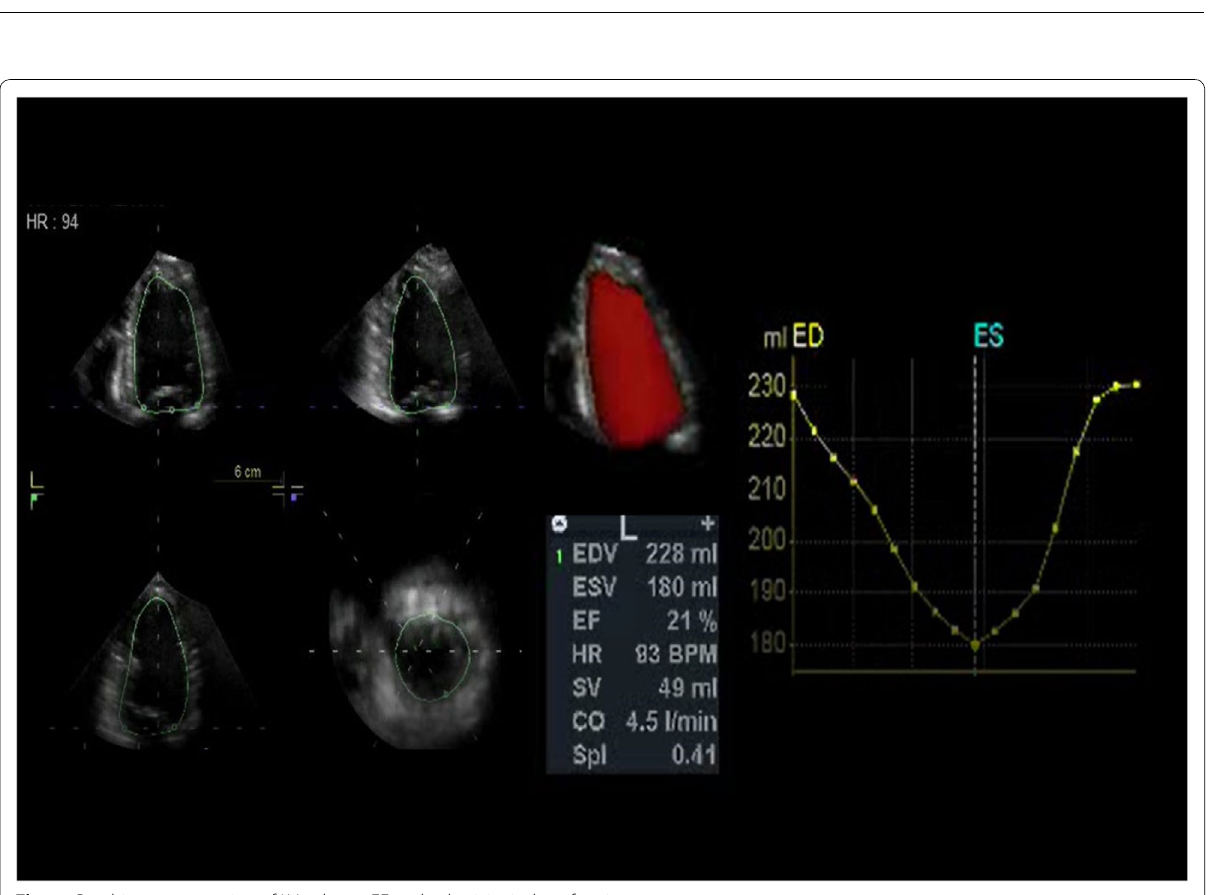
Fig. 1 Graphic representation of LV volume, EF and sphericity index of patient